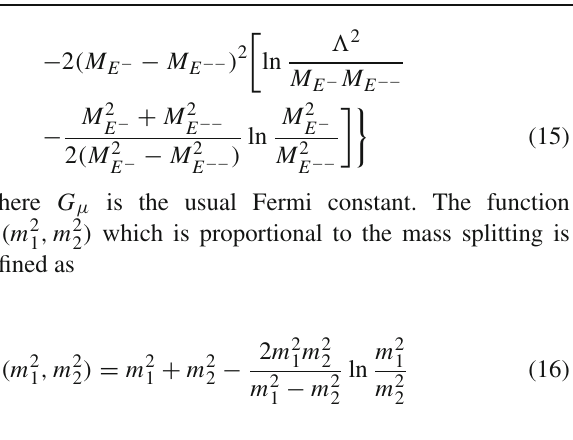
indicated by the dot-dashed brown line, due to upper experi-